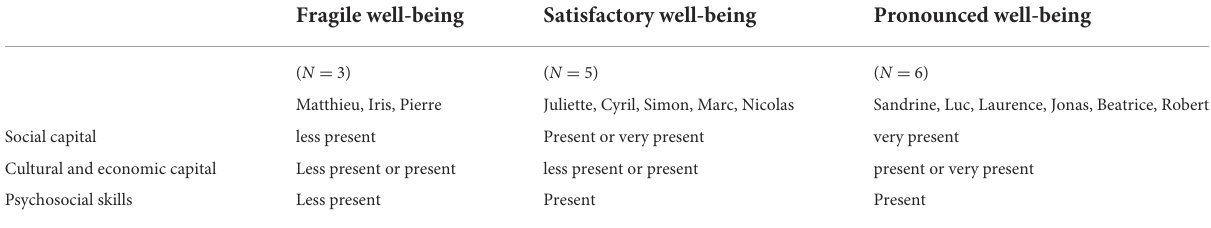
TABLE 2 Level of well-being, in couples with reduced working